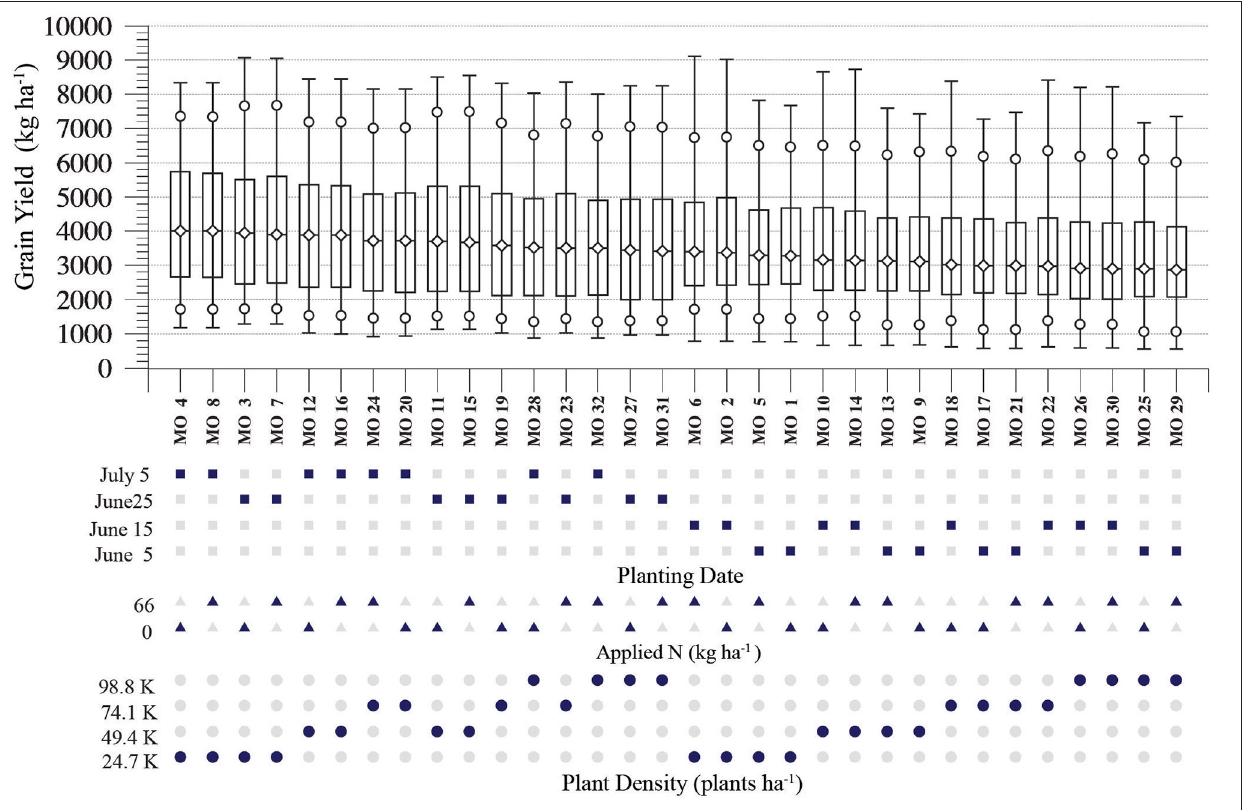
FIGURE 4 | As in Figure 3a , with each management option’s yield distribution plotted in order from the highest to the lowest median grain yield.